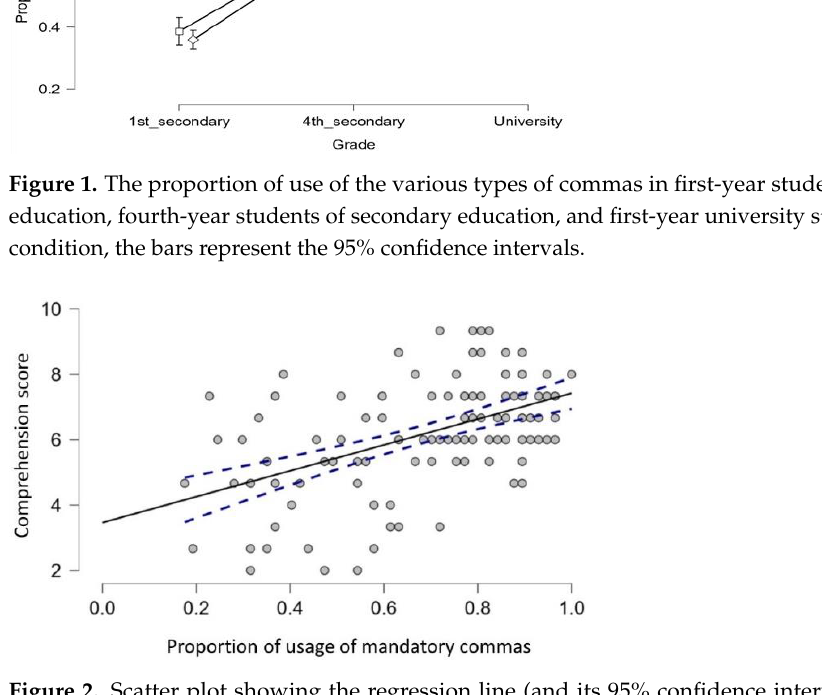
Figure 2. Scatter plot showing the regression line (and its 95% confidence interval) between the secondary-education students’ use of commas (proportion of correct use in the sentences) and their reading comprehension